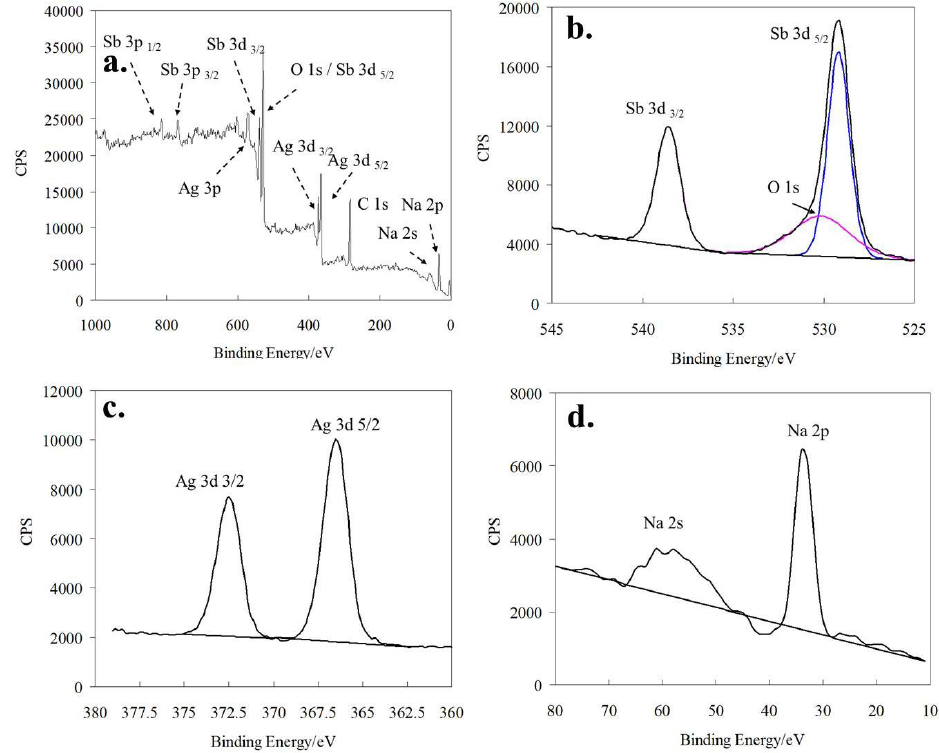
Figure 8. The wide scan XPS spectra (a) of ANS Catalyst; The high-resolution XPS spectra of (b) O1s and Sb 3d, (c) Ag3d, (d) Na2p and